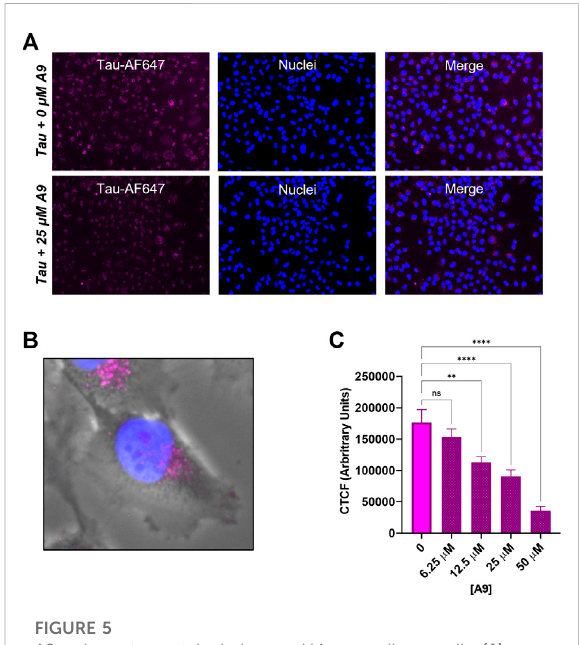
FIGURE 5 A9 reduces tau uptake in human H4 neuroglioma cells. (A) Microscopy images of tau uptake assay. H4 cells were treated with 0.1 μ M tau-AF647 in the presence and absence of 25 μ M A9. Tau- AF647 was imaged using the CY5 channel, nuclei were stained with Hoechst 33258 and imaged using the DAPI channel. (B) Magni fi cation of a single cell showing tau uptake localized aroundtheparanuclearregion. (C) Quanti fi cationof5Aisreported asCorrectedTotalCellFluorescence(CTCF),whichshowsadose- dependent inhibition of tau internalization by